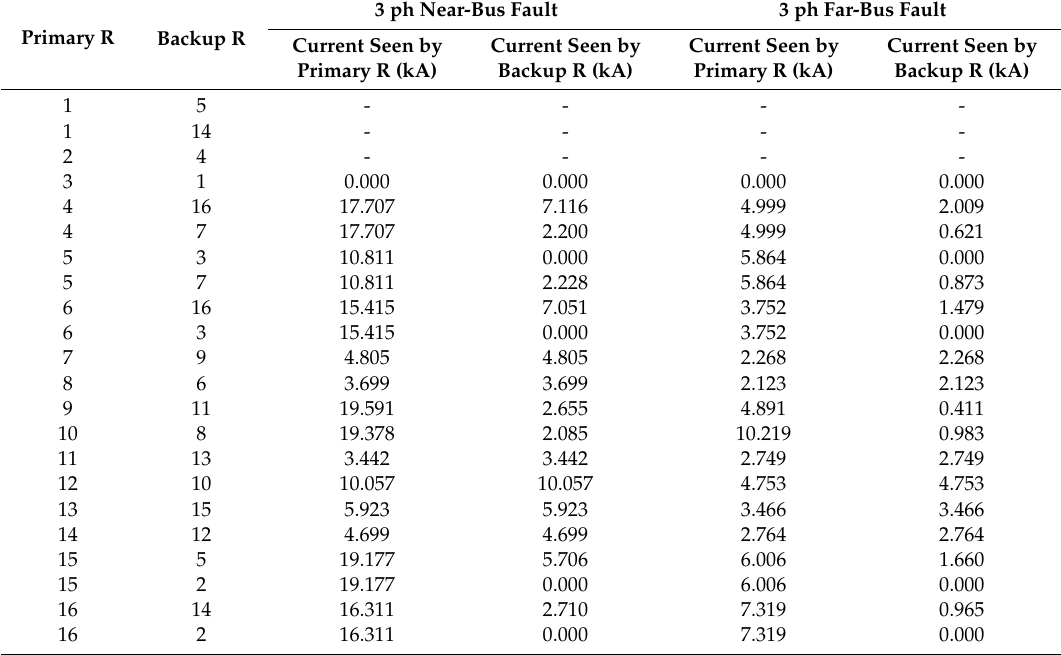
Table 8. Fault currents through primary and backup relay pairs for topology